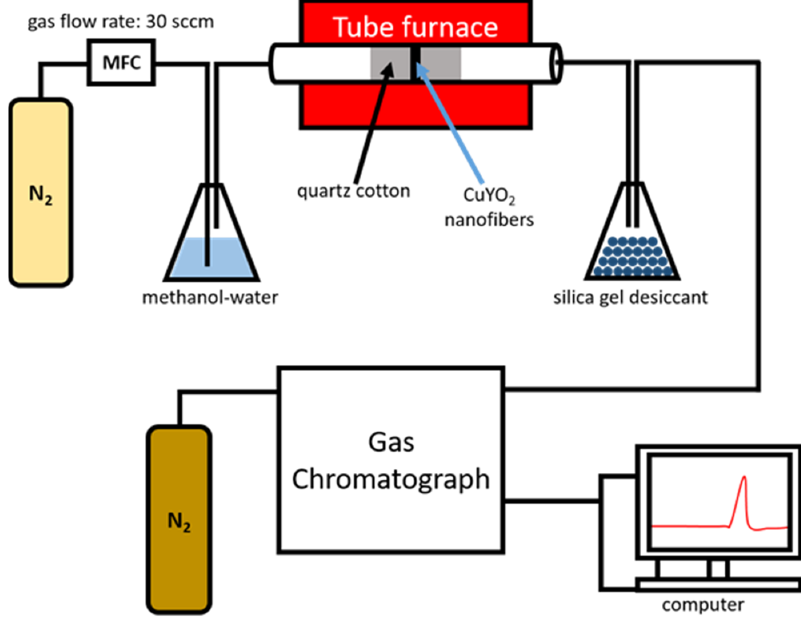
Figure 10. Schematic diagram of the steam reforming of methanol.